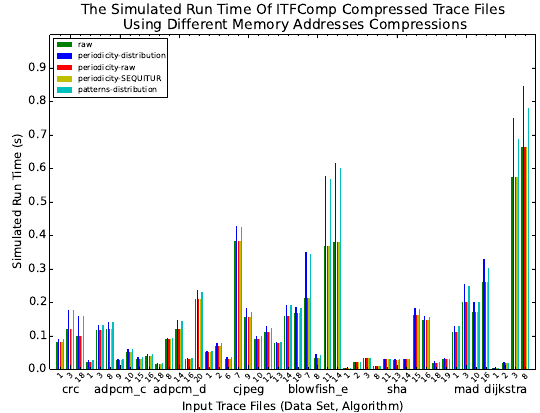
Figure 5: The simulated run time of compressed ITFs using different data memory addresses compression techniques in ITFComp.